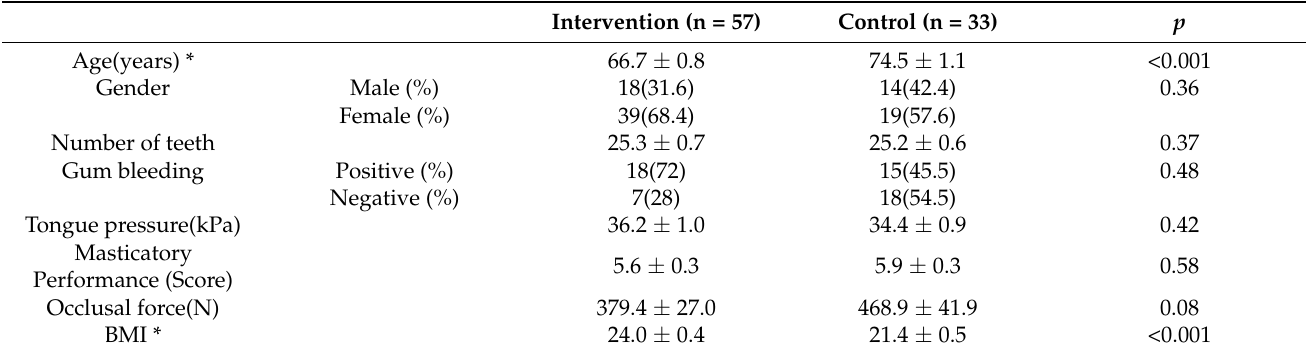
Table 1. Participant characteristics of each group before intervention.